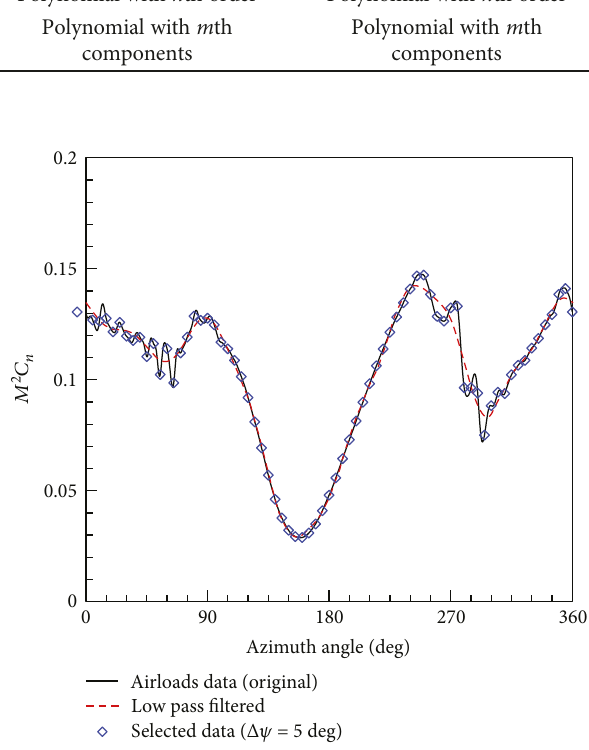
Figure 5: Comparison of data selection schemes on airloads